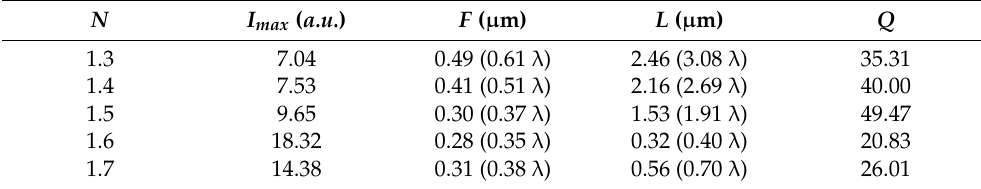
Figure 6. Comparison of full width at half maximum F of the SPP − PNJ with different dielectric mi- crodisk refractive indices n . Table 1. Characteristic parameters of an SPP-PNJ excited with different refractive indices n of the dielectric